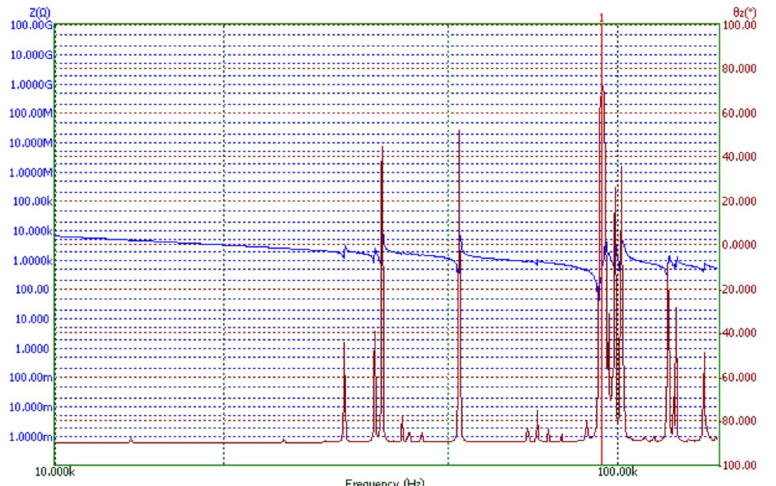
Figure 16. Impedance/phase diagrams of the piezoelectric cylinder. A resonant frequency for driving a transducer is 93.6 kHz.